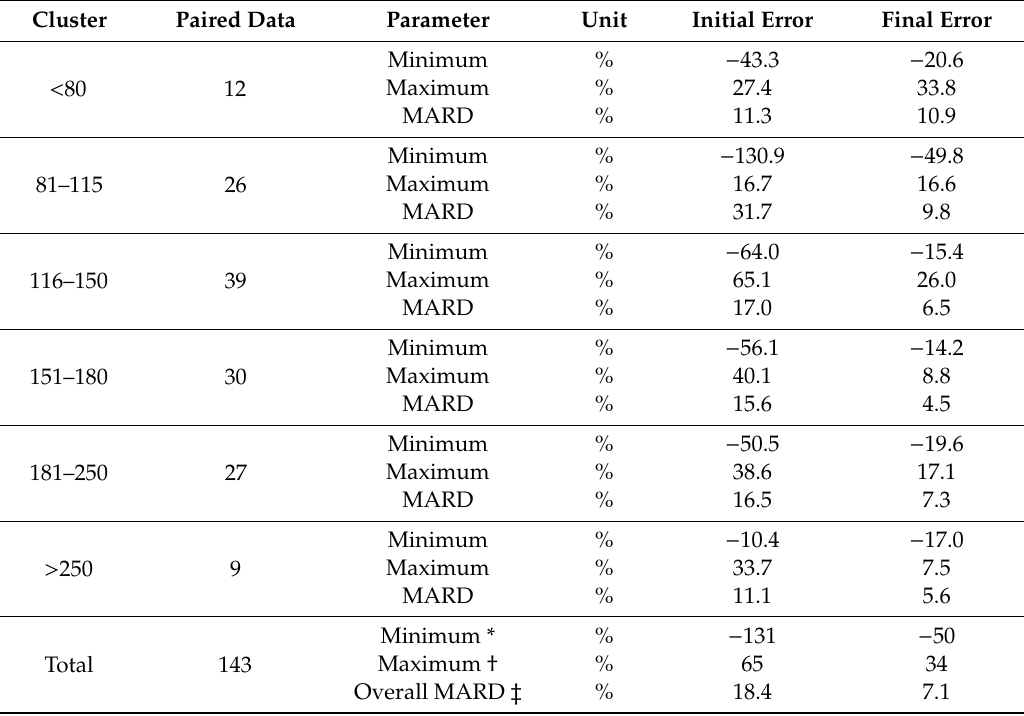
Table 12. Results of the PGMS applied to the dataset